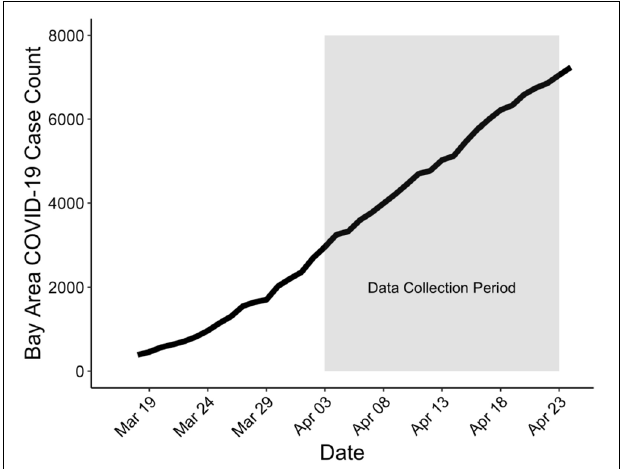
FIGURE 1 | Timeline of data collection in the current study (highlighted in gray) relative to rising cases in the San Francisco Bay Area.